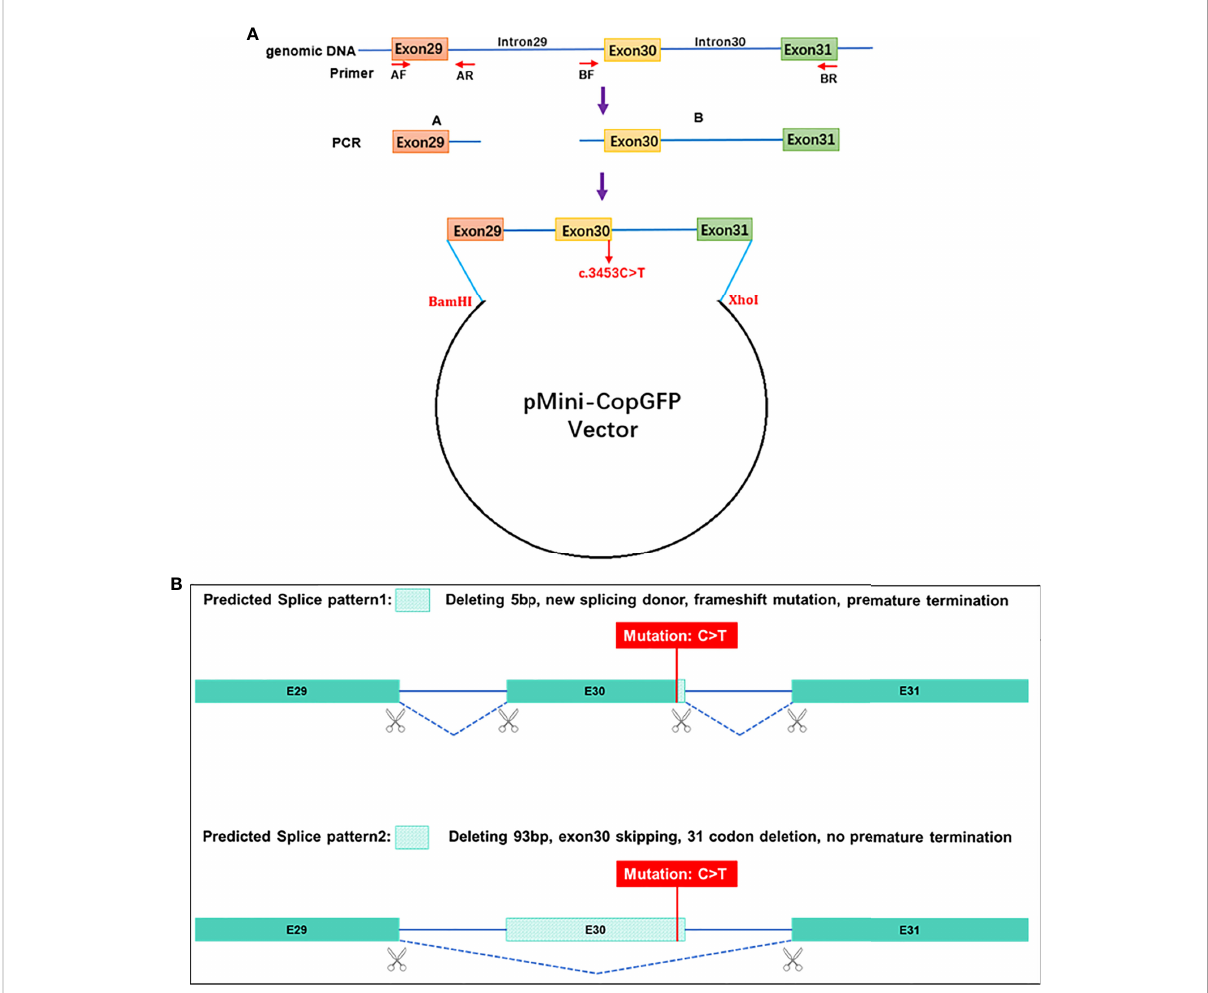
FIGURE 3 Schematic diagram for the synonymous mutation c.3453C>T affecting splicing. (A) Plasmid construction fl ow chart; (B) the online RNA Splicer tool predicted two splice patterns, pattern 1 with 5 bp deleting and pattern 2 with exon 30 (93 bp)